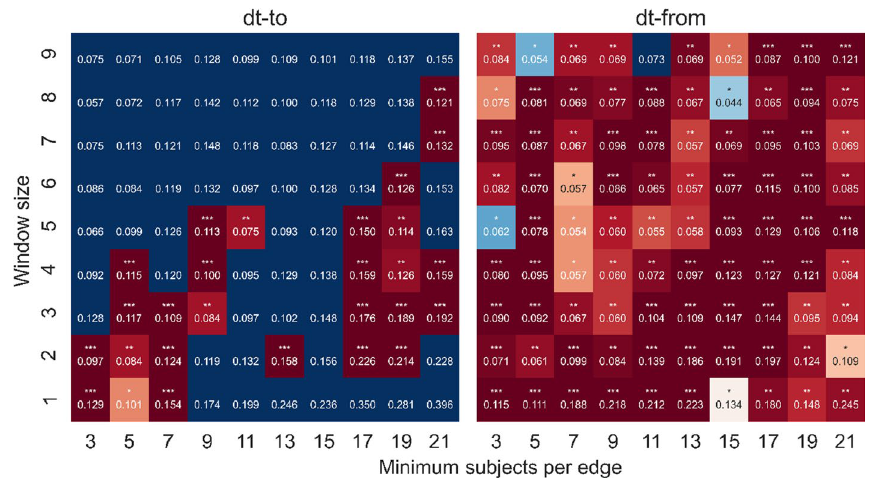
Fig. 12 Interactions between location and LDC on dt-to and between location and LDC on dt-from. The color highlights the sign and magnitude of the beta coefficients. A blue cell indicates a non-significant beta. By contrast, the redder the cell is, the greater the beta coefficient is. The number of stars indicates the level of significance